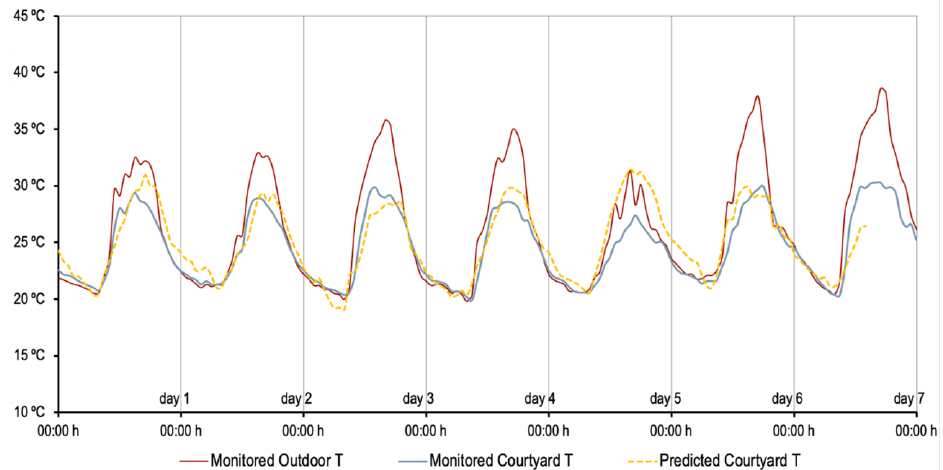
Figure 3. Example 3.0.1. Predicted temperature versus monitored and outdoor temperatures inside a TR2